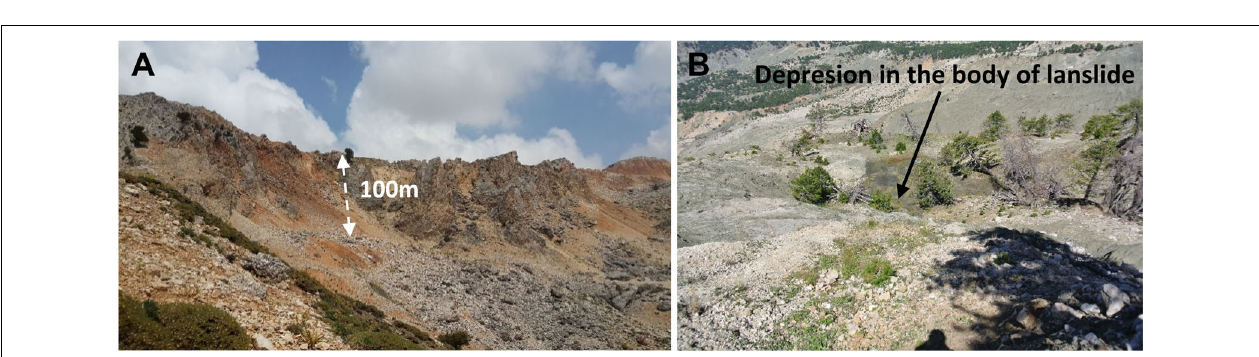
FIGURE 12 | (A) Different lithology and forms of erosion in the landslide. (B) Gully erosion (in Figure 4 , the viewpoints of photographs are marked).